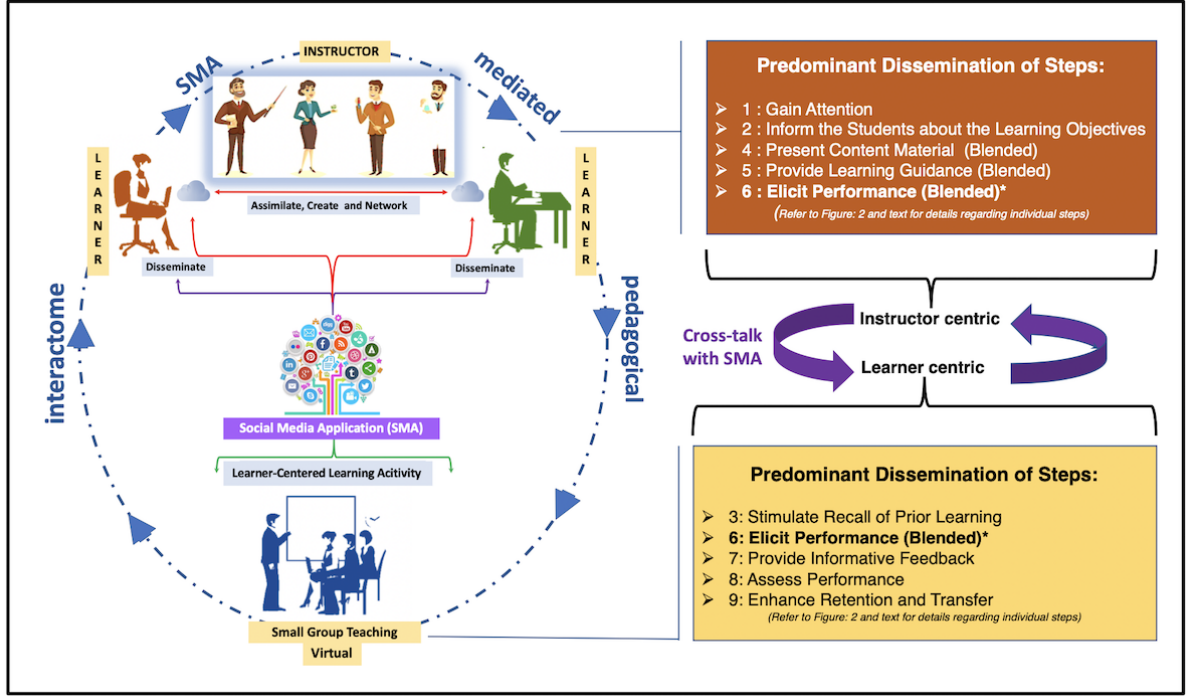
Figure 4. The SMA (social media application) interactome. The dissemination of the teaching framework using SMA during the unprecedented times of COVID-19 is shown. The interactome consists of two aspects, one of which is instructor centric whereas the other is learner centric. Individual steps of the teaching framework attesting to the two aspects in shown. Step 6 is common to both the aspects (indicated by *). The crosstalk between the two aspects is facilitated by SMAs (YouTube and WhatsApp at the Mohammed Bin Rashid University of Medicine and Health Sciences, and also through discussion sessions on the learning management system at the